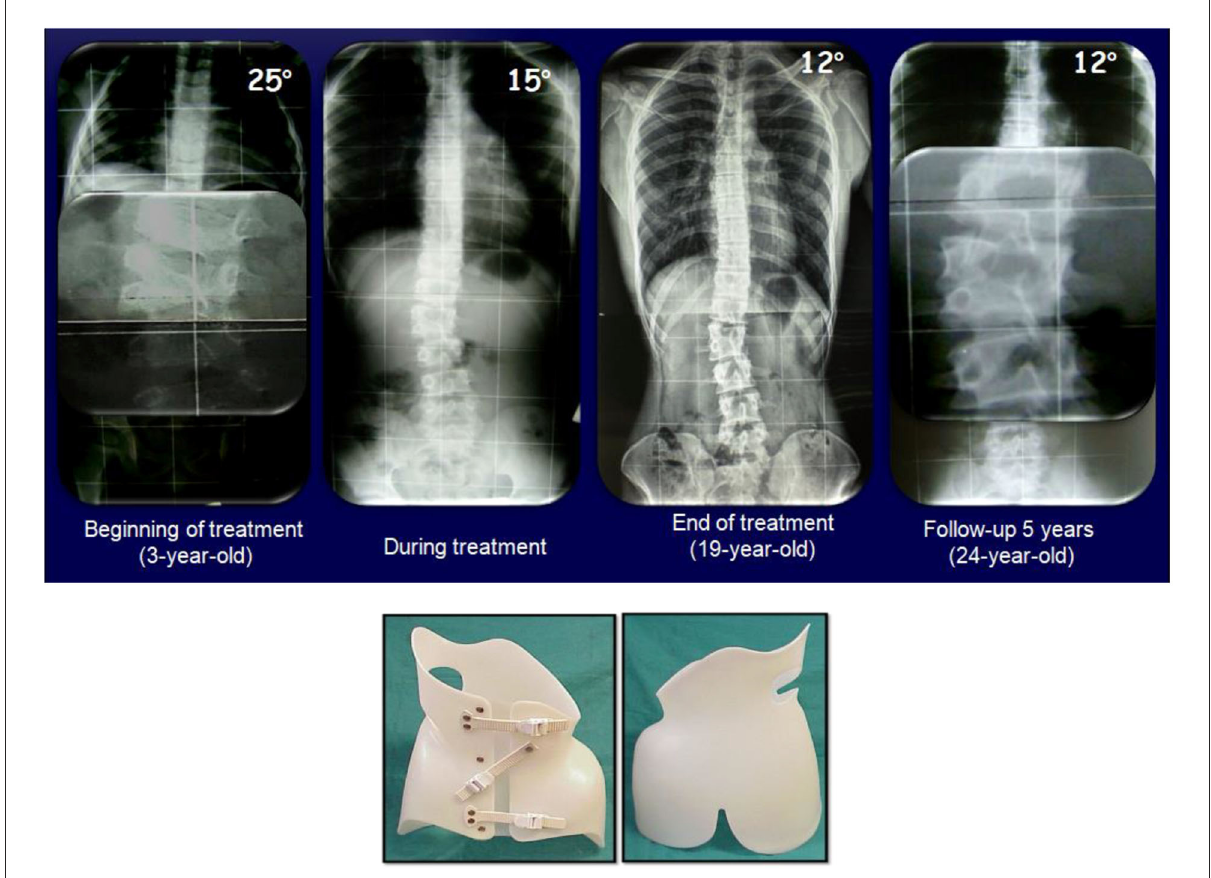
FIGURE3 A 3-years-old male with a hemivertebra in L3 (in a 6 lumbar body) and a T12-L4 curve treated conservatively the PASB.